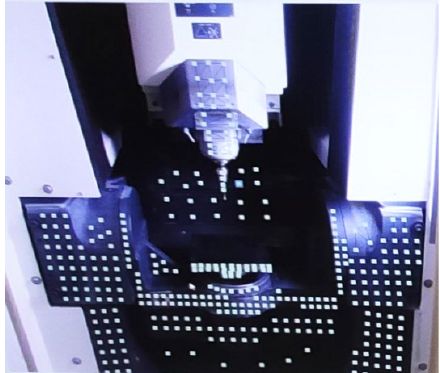
Fig. 3. Overview of measuring points, which were set individually in the object